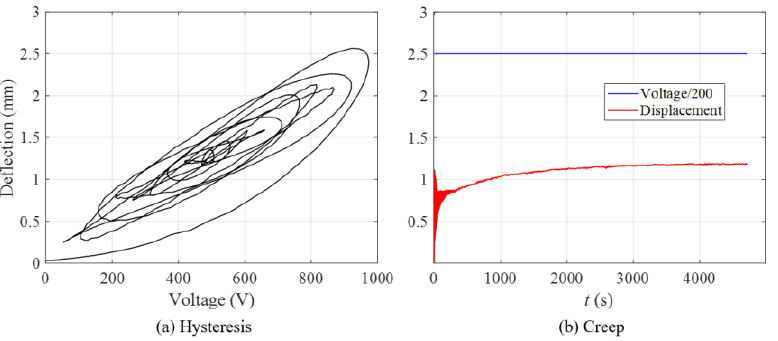
Figure 11. Hysteresis and creep effects of the MFC actuator. ( a ) Hysteresis effect of the MFC actuator; ( b ) creep effect of the MFC actuator.